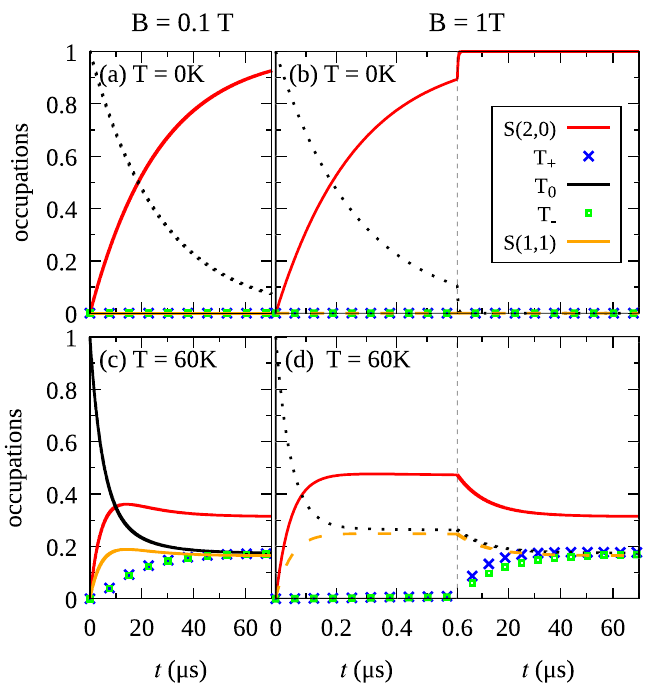
26 kV/cm. The vertical dashed lines divides two scales =